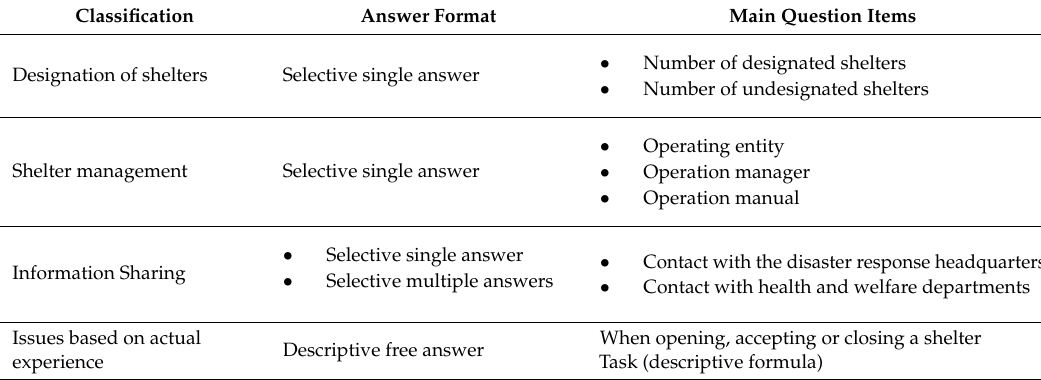
Table 2. The structure of the survey.